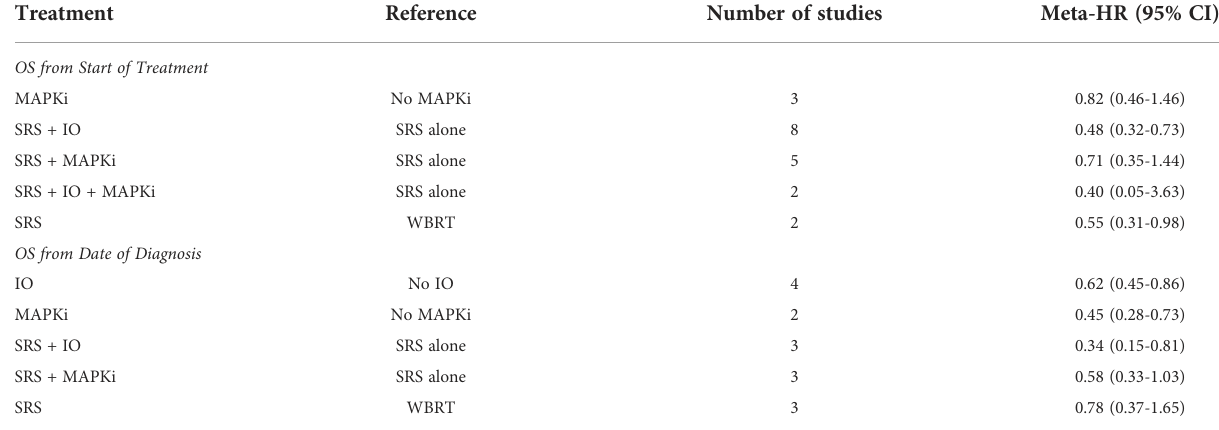
TABLE 2 Meta-analysis by treatment for overall survival (OS) in observational